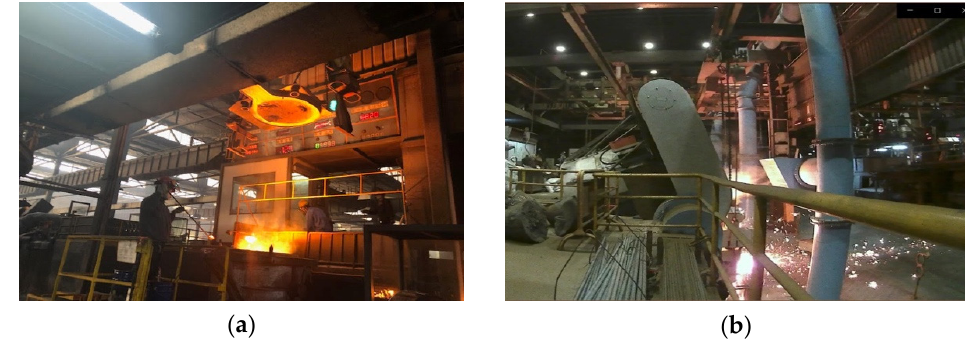
Figure 3. ( a ) Removing dross manually; ( b ) the molten metal is poured into the hanging pot.